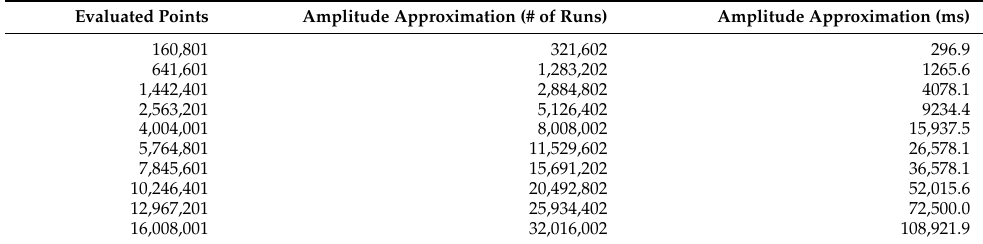
Table A3. Measurement results without pre-filtering with 2